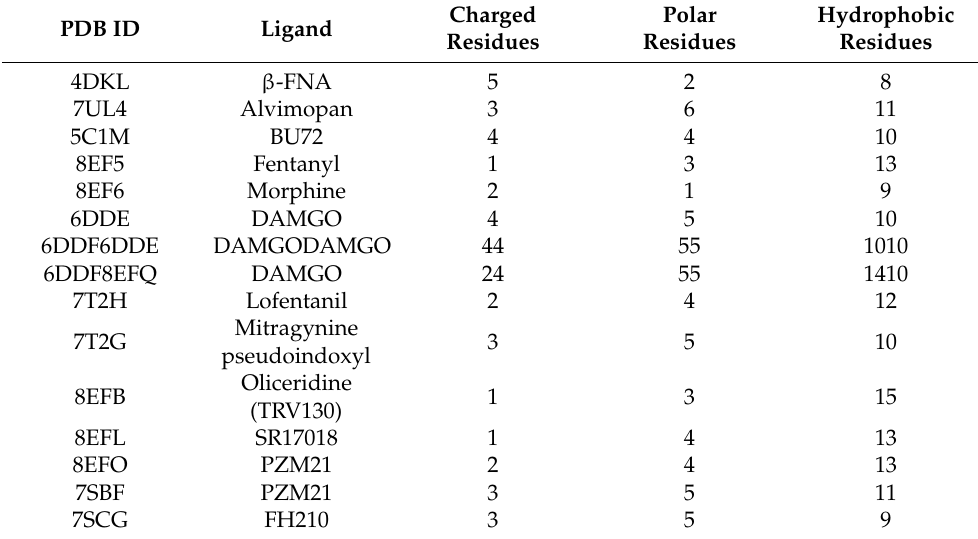
Table 4. Binding pocket residue composition of each structure (residues within 5 Å of the ligand are